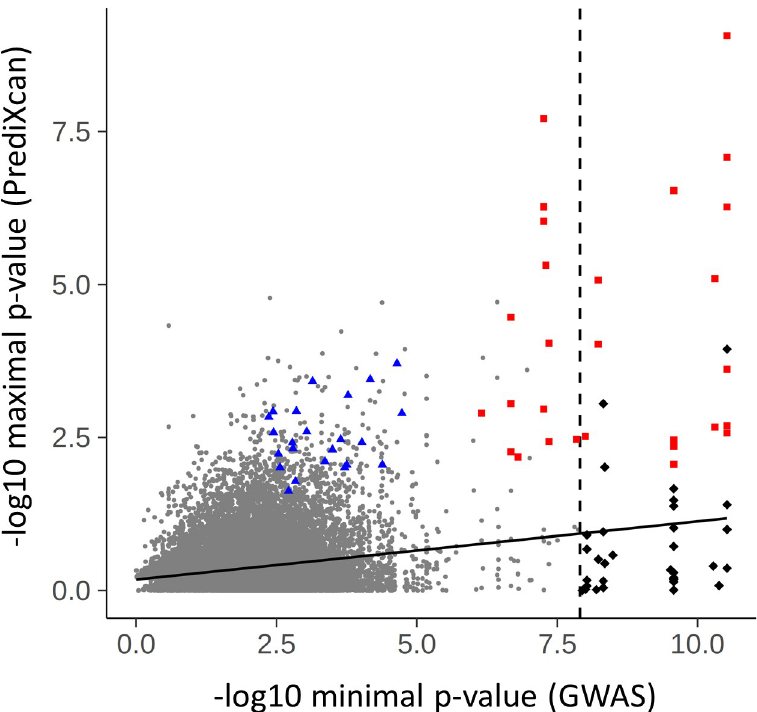
Fig 4. Correlation of imputed gene expression association from PrediXcan and minimal GWAS association p- values. Maximal p-values between HMP and EBM meta-analyses of CF lung disease associations from imputed gene expression (PrediXcan) for 26,750 genes from 48 GTEx tissues are plotted against minimal GWAS SNP p-values per gene among all cis -SNPs used in predictive models. The 52 consensus modifier genes are highlighted in red squares (near GWAS loci) and blue triangles (novel), while genes with minimal GWAS SNP p-values < x10 -08 (dashed vertical line), but not among the 52, are highlighted in black diamonds. Solid line represents linear